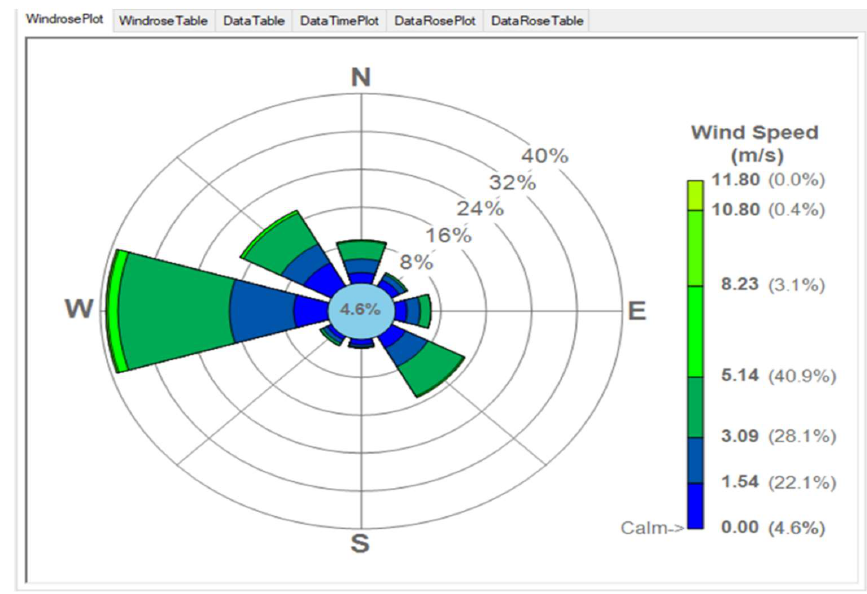
Figure 8. The wind rose made with the AerMet module for the area of interest .